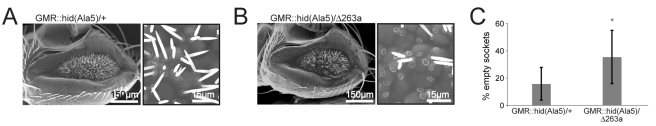
miR-263a limits Hid activity during eye development.(A, B) SEM of adult eyes that express the activated form of hid under GMR control. (A) GMR:hid(Ala5) alone (B) GMR:hid(Ala5) lacking one genomic copy of miR-263a. (C) Quantification of missing IOB from flies of the genotypes shown in (A) and (B). The number of IOB socket cells devoid of a shaft cell was normalized to the total number of socket cells. Error bars represent mean ± SD for N = 10–15 flies per genotype. [*] p<0.005, Student's t test comparing to GMR:hid(Ala5)/+.